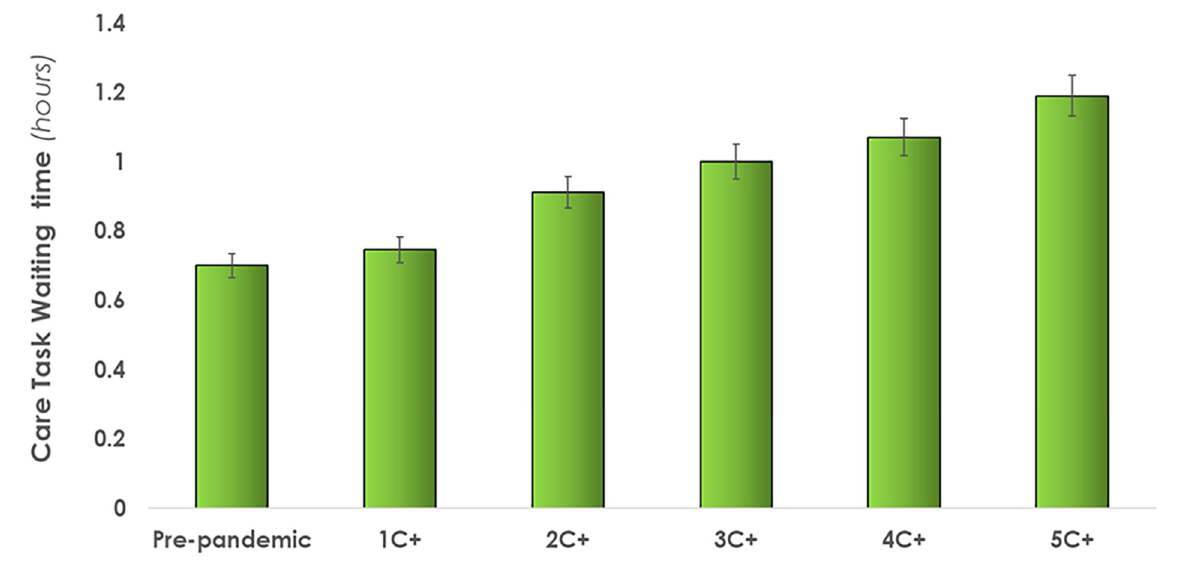
Fig 9. Average care task waiting time within a shift as COVID-19 positive (C+) patients increased from 1 to 5. Error bars indicate standard deviations. Table 3 provides a summary of the quantitative results.